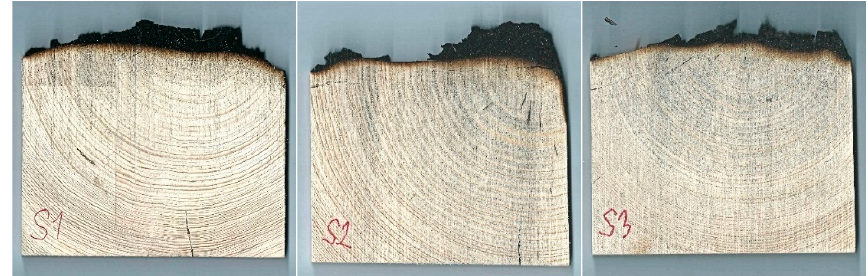
Figure 11. Sample slices—Norway spruce prisms.